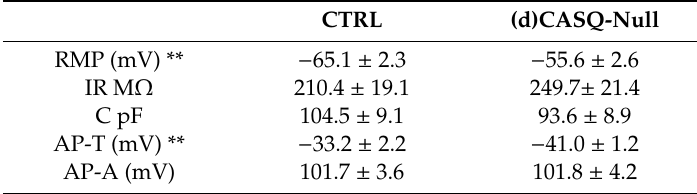
Table 1. Electrophysiological properties of CA1 neurons in CTRL and (d)CASQ-null mice.